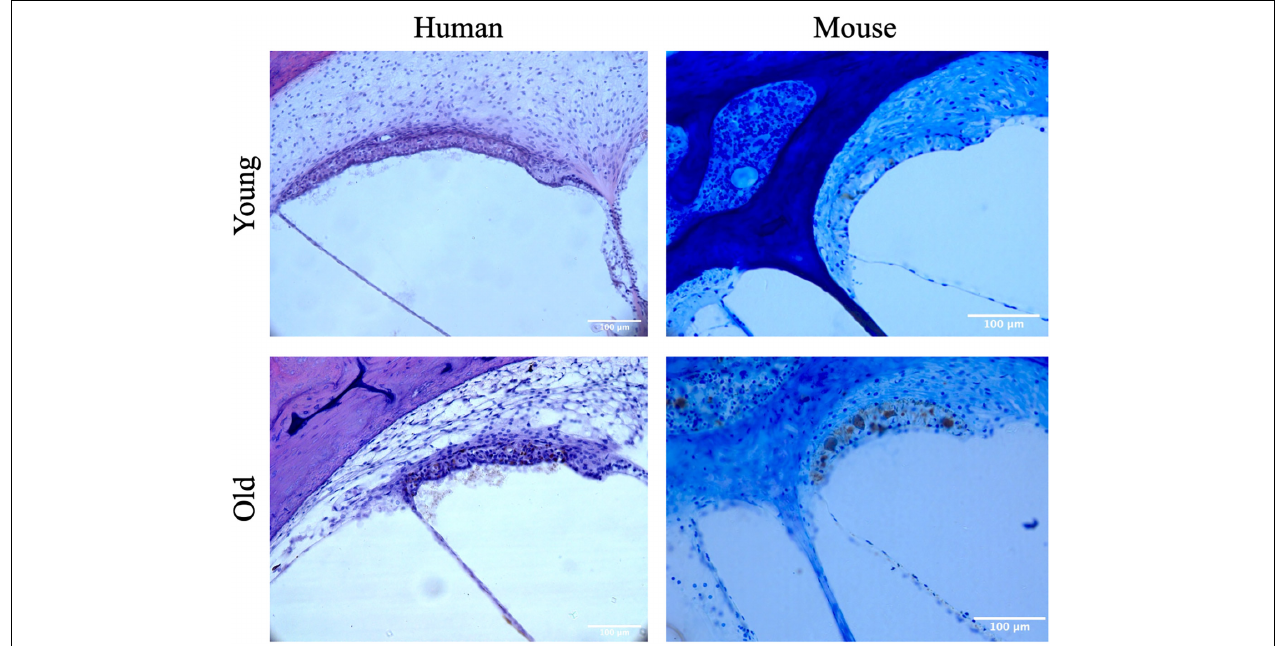
FIGURE 2 | Representative images of the stria vascularis from young and aged mice and humans.